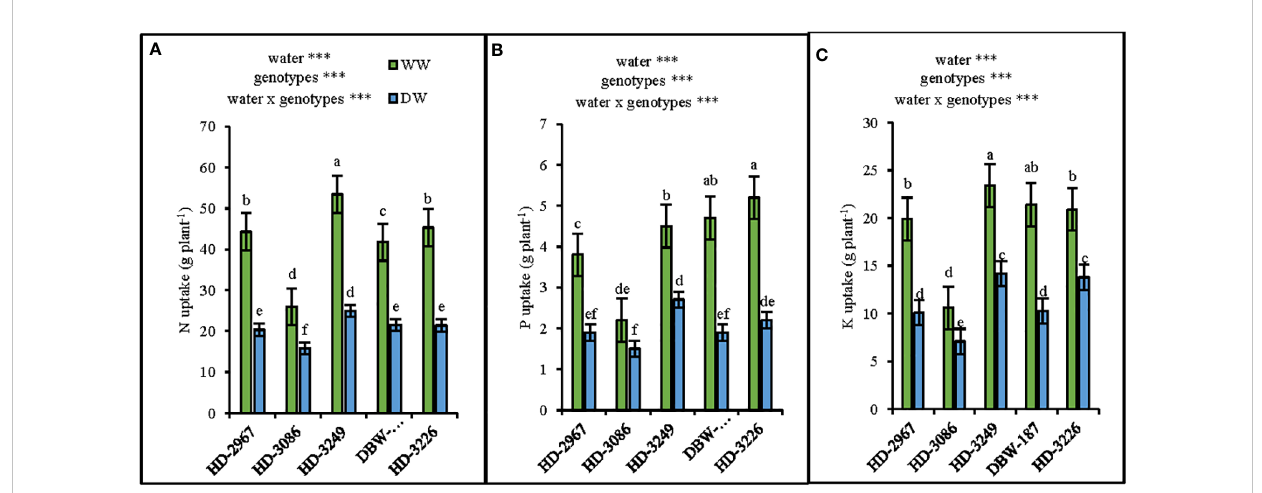
FIGURE 6 Nutrients uptake of fi ve wheat genotypes at maturity (Z89) grown under well- (WW) and de fi cit (DW) watered conditions. (A) : Nitrogen uptake, (B) : Phosphorus uptake, and (C) : Potassium uptake. Letters above the bars indicates signi fi cant difference among genotypes at p<0.05 (Turkey;s HSD test) Signi fi cant at *0.02, **0.01, and ***0.001 probability